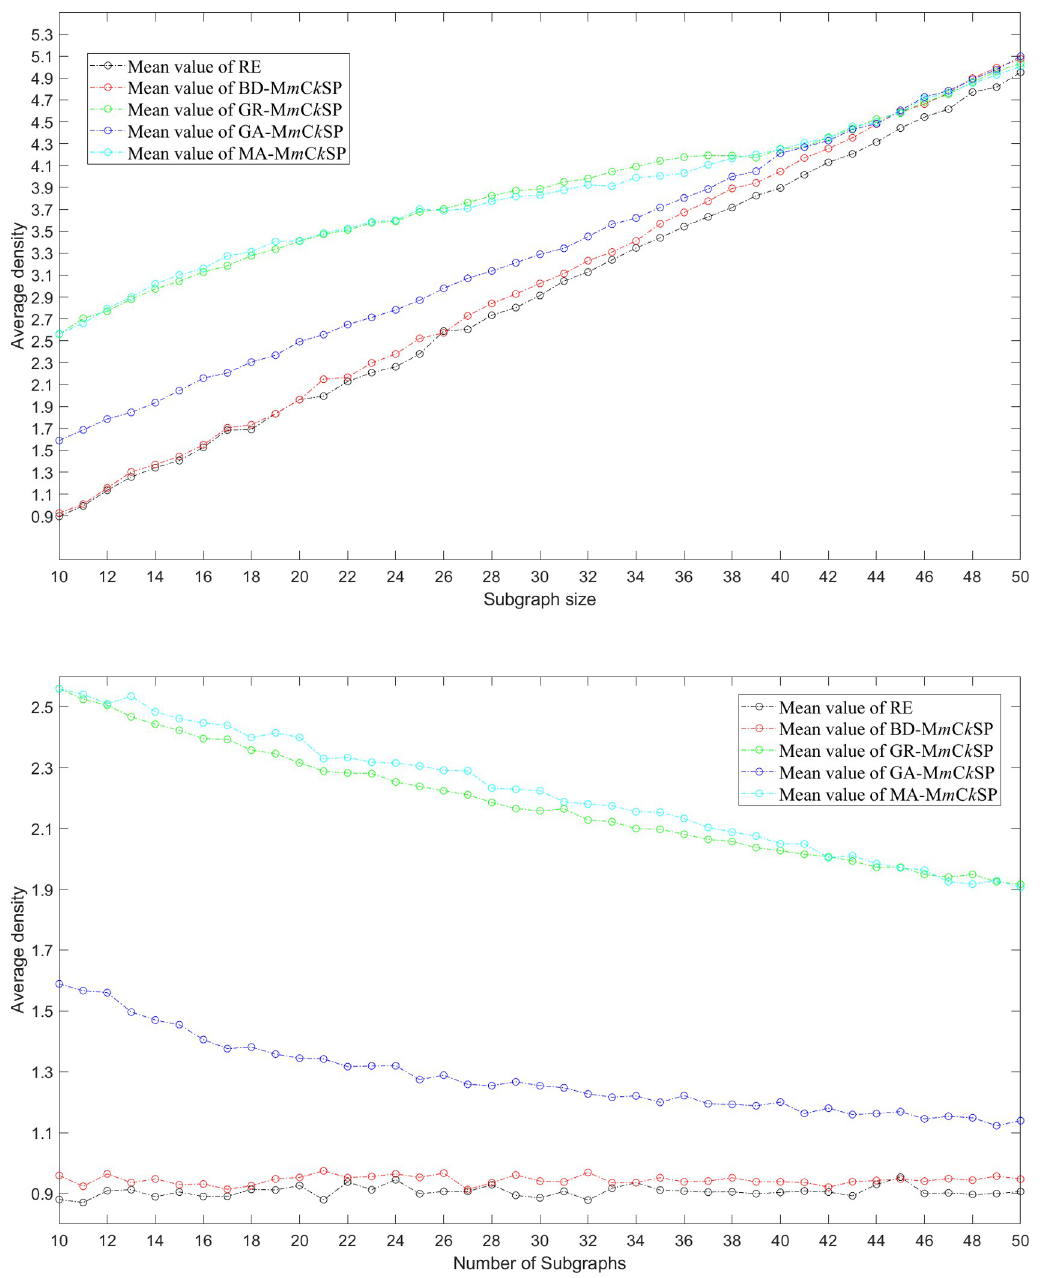
Fig 9. Average density of the extracted subgraphs for RE, BD-M m C k SP, GR-M m C k SP, GA-M m C k SPand MA-M m C k SP. (a) shows the result for different subgraph sizes given the number of subgraphs m = 10; (b) shows the result for different numbers of subgraphs given the subgraph size k =